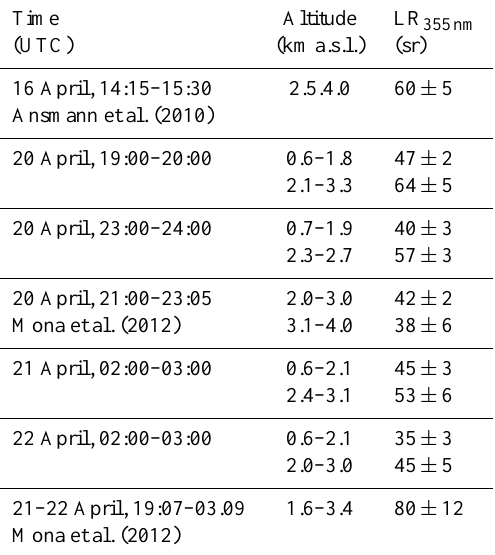
Table 1. Mean values and standard deviations of the lidar ratios at 355nm retrieved at Lecce, Potenza, and Leipzig on different days and hours and at different altitude